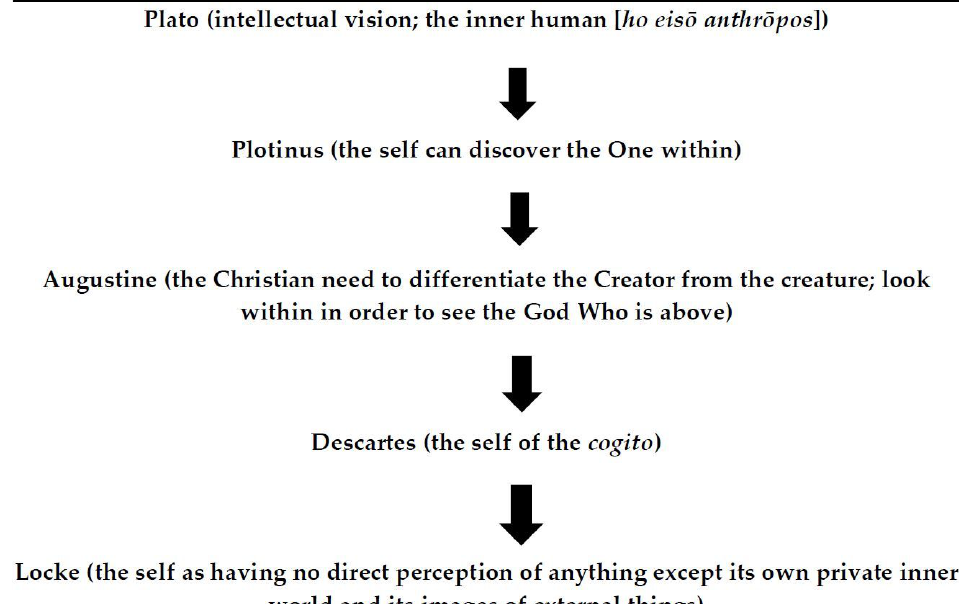
Figure 1. Tracing the notion of inwardness in Taylor’s Sources of the Self (Taylor